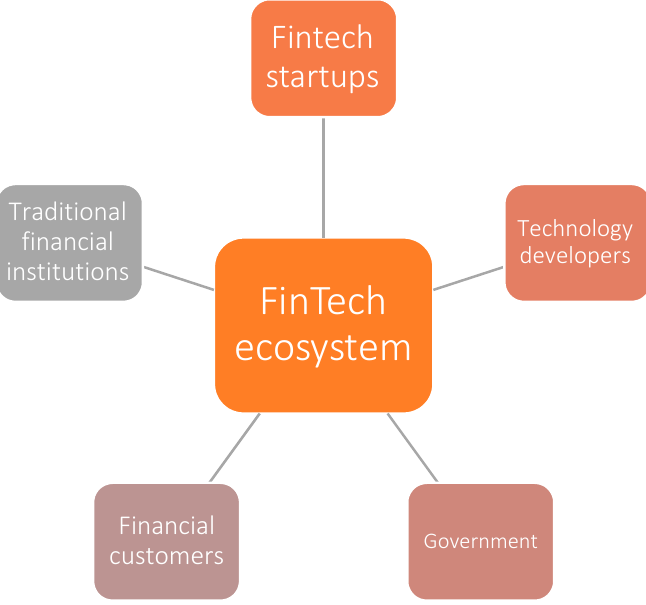
Figure 7. The five elements of the FinTech ecosystem. Source: Lee and Shin (2018).